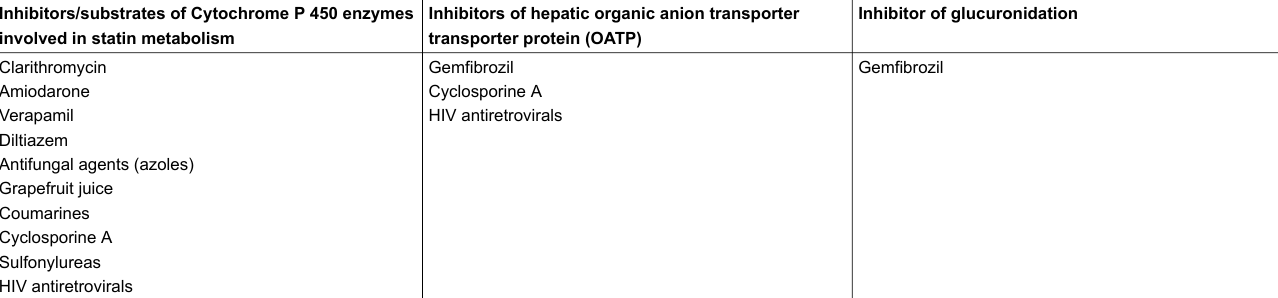
Table 1: Compounds interacting with statin metabolism. Frequently administered drugs that may increase statin levels and toxicity by different mechanisms. The list is not exhaustive. Inhibitors/substrates of Cytochrome P 450 enzymes involved in statin